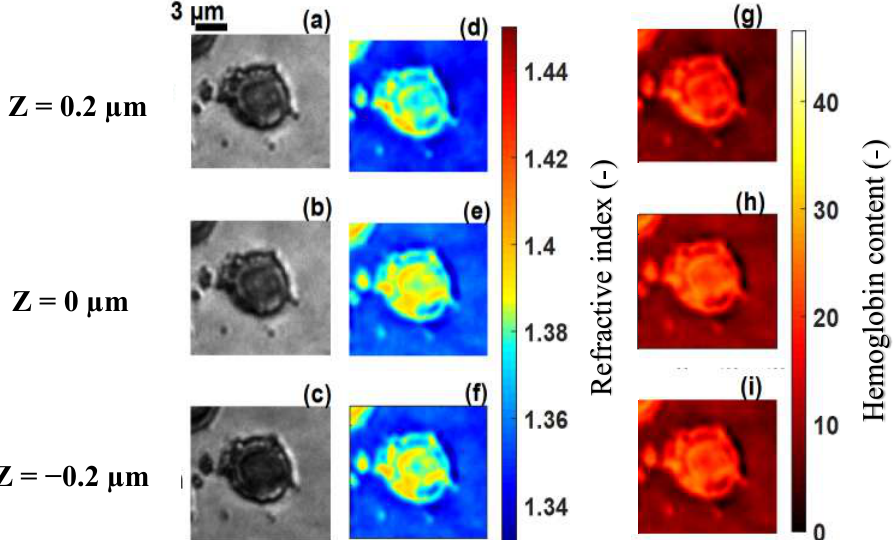
Figure 7. Recorded images of infected cell C at the trophozoite stage, at the wavelength λ = 800 nm for different z planes ( a )–( c ), its corresponding refractive index distribution ( d )–( f ) and hemoglobin content ( g )–( i ). The selected images are representative of a total of 42 cells analyzed.